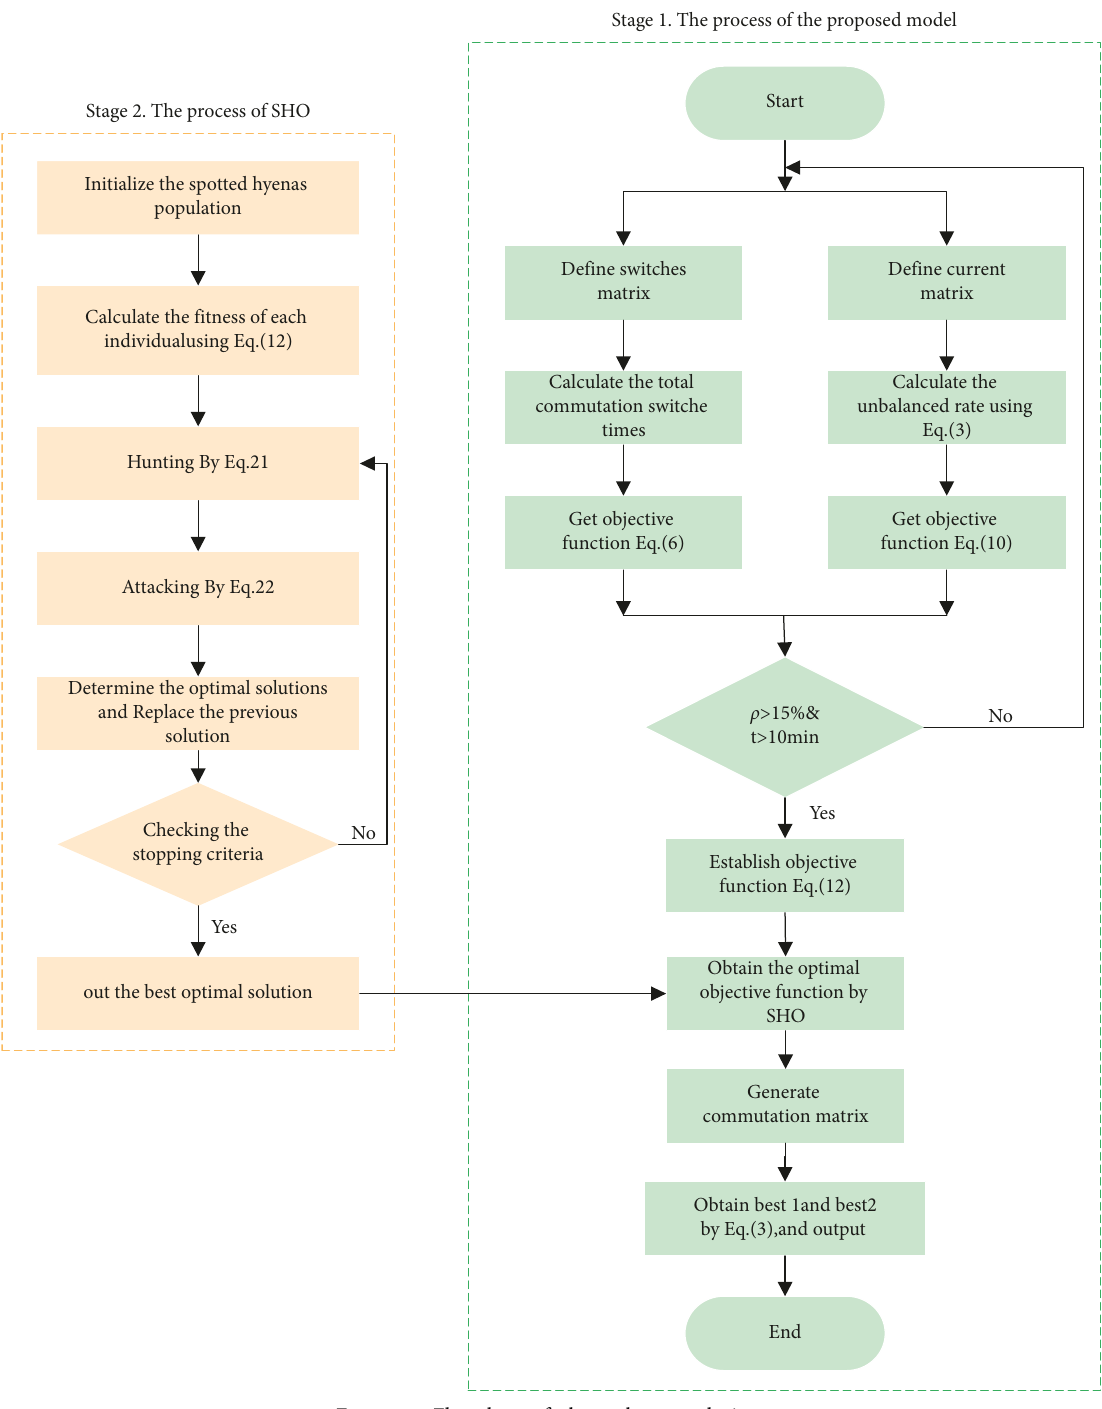
Figure 5: Flowchart of phase-change solution. Table 1: Value of current before